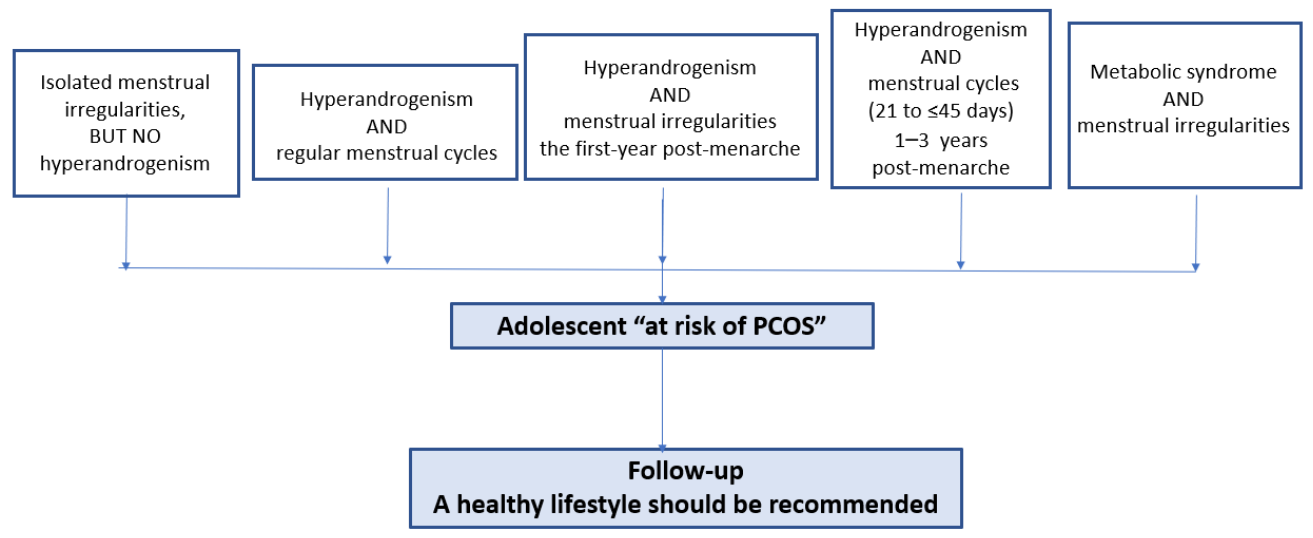
Figure 2. Definitions of adolescents “at risk of PCOS”.